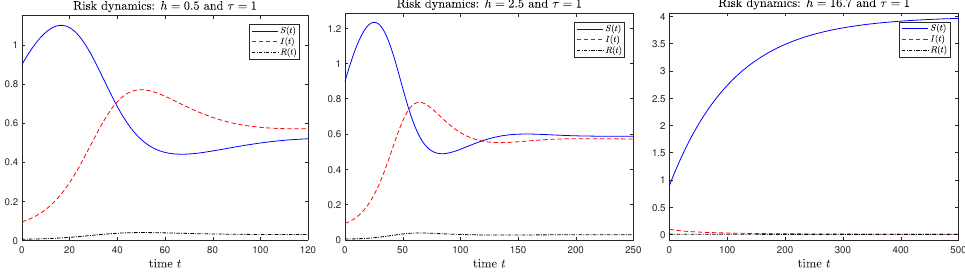
Figure 3. Dynamics related to the first scenario: financial immunity period is τ = 1. Incubation time varies from h = 0.5 (on the left ) to h = 2.5 (in the middle ) and h = 16.7 (on the right ). Solid blue line: susceptible dynamics. Dashed red line: infected dynamics. Dash dot black line: recovered dynamics.